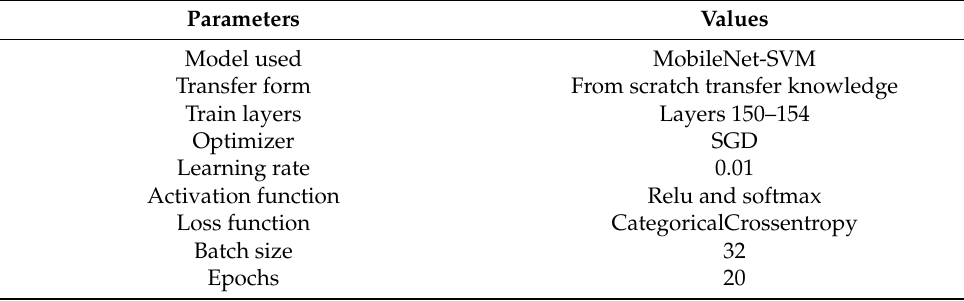
Table 6. Implementation parameters